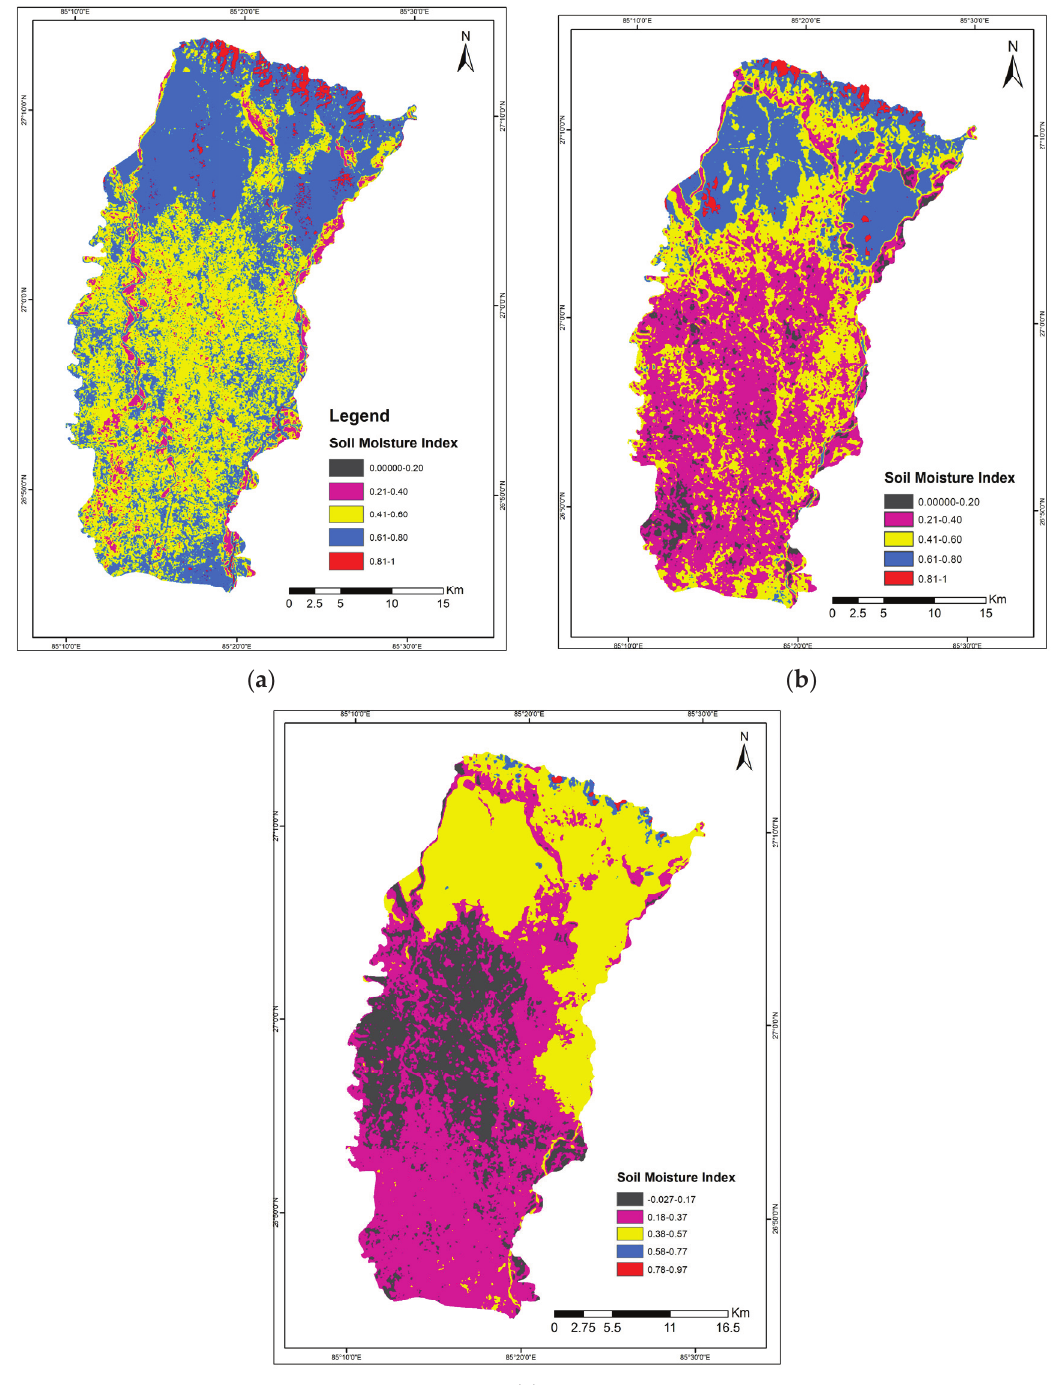
Figure 4. Soil moisture index of Rautahat district in different years: ( a ) 2000; ( b ) 2014; and ( c ) 2015.